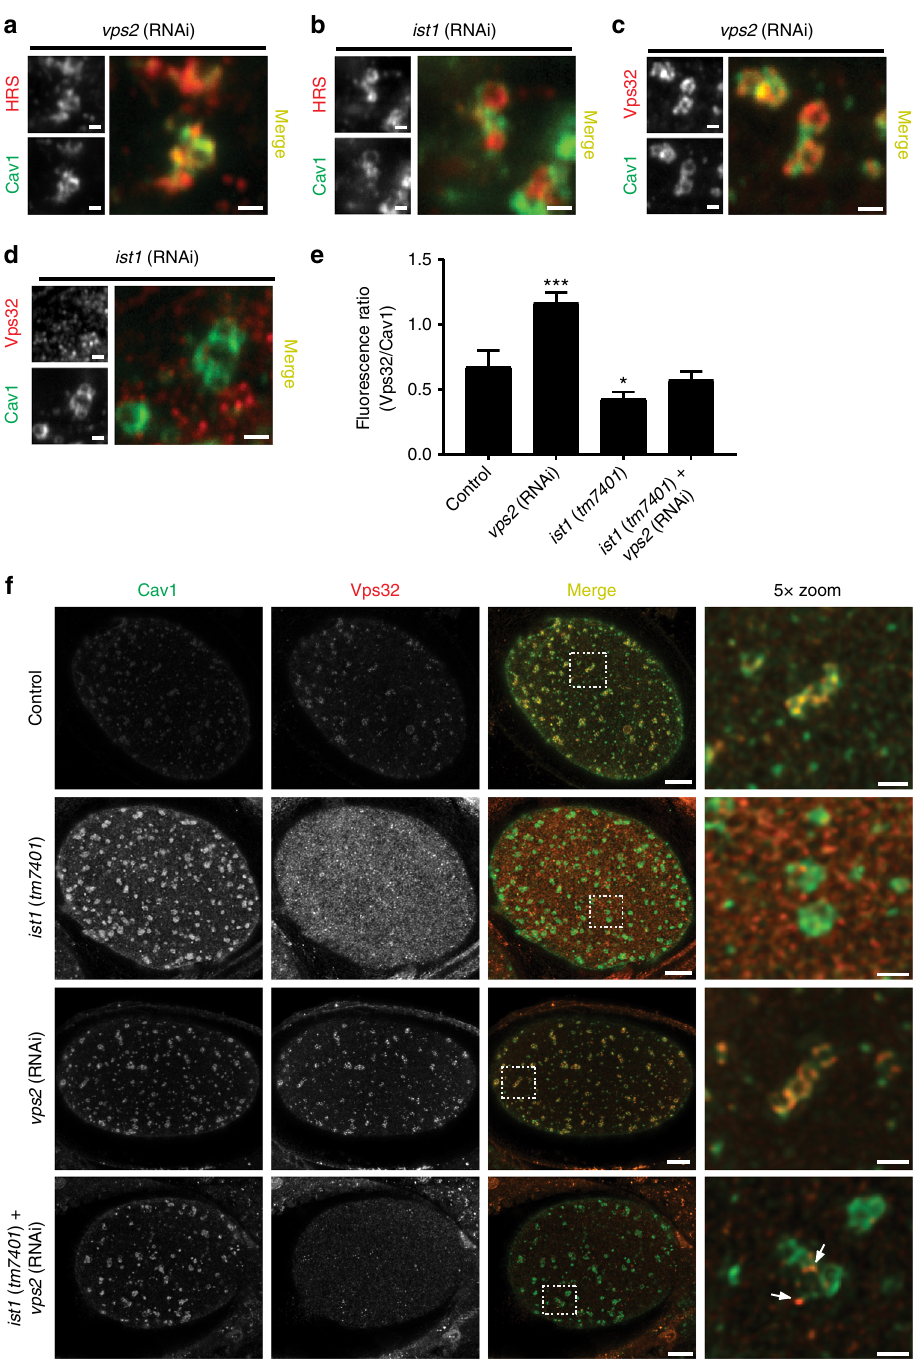
Fig. 5 Ist1 controls Vps32 assembly on endosomes. a – d One-cell stage embryos expressing GFP::Cav1 and depleted of either Vps2 ( n = 13, each condition) or Ist1 ( n = 11, each condition) were fi xed and stained using antibodies directed against GFP and either Hrs or Vps32 and imaged using confocal microscopy. Representative images are shown. Bars, 1 μ m. e Quanti fi cation of the relative fl uorescence intensities of Vps32 and Cav1 under various conditions based on STED imaging (see panel f ). Standard error of the mean is reported in each case. *** p < 0.001 as compared to control, using a t -test; * p < 0.05 as compared to control, using a one-way ANOVA with Dunnett ’ s test. f One-cell stage control ( n = 10, each condition) and ist1 ( tm7401 ) mutant embryos ( n = 20, each condition) expressing GFP::Cav1 in the presence or absence of Vps2 were fi xed and stained using antibodies directed against GFP and Vps32 and imaged using STED microscopy. Arrows highlight the presence of subdomains containing Vps32. Representative images are shown. Bars, 5 μ m (left panels) and 1 μ m (right, zoomed